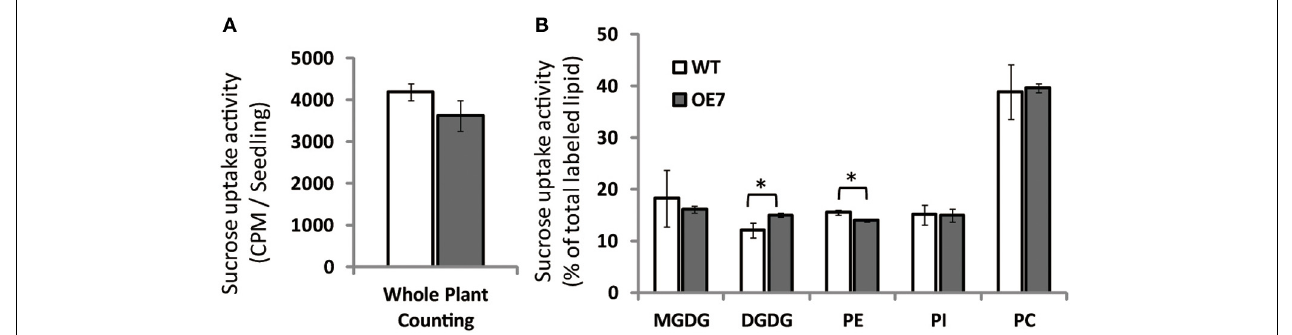
FIGURE 9 | Sucrose uptake of WT and OE7 plants. Plants were grown on sucrose-free ½MS for 2 weeks and then transferred to 14 C-labeled sucrose containing ½MS for 4h. (A) Counts of 14 C-labeled whole seedlings. (B) Relative intensity of 14 C-labeled membrane lipids.